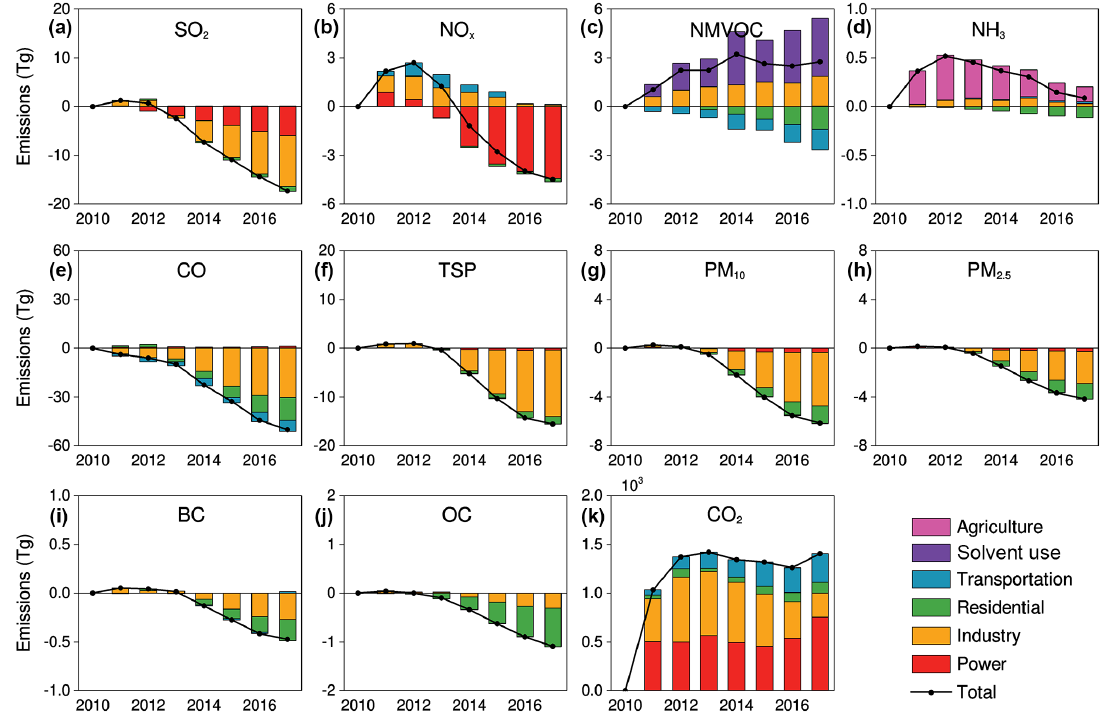
Figure 4. Changes in China’s emissions by sector and year. The species plotted here include (a) SO 2 , (b) NO x , (c) NMVOCs, (d) NH 3 , (e) CO, (f) TSP, (g) PM 10 , (h) PM 2 . 5 , (i) BC, (j) OC, and (k) CO 2 . The 2010 emissions are subtracted from the emission data for each year to represent the additional emissions compared to 2010 levels. The emission changes are shown by sector (stacked column chart) and as national totals (black